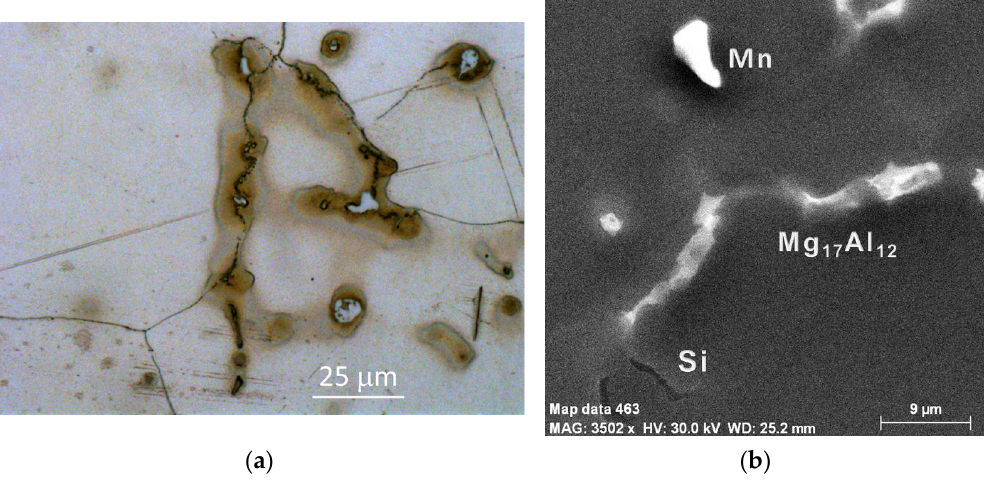
Figure 1. Microstructure of the as-prepared AZ31 alloy: ( a ) light micrograph; and ( b ) scanning electron micrograph showing identified phases.